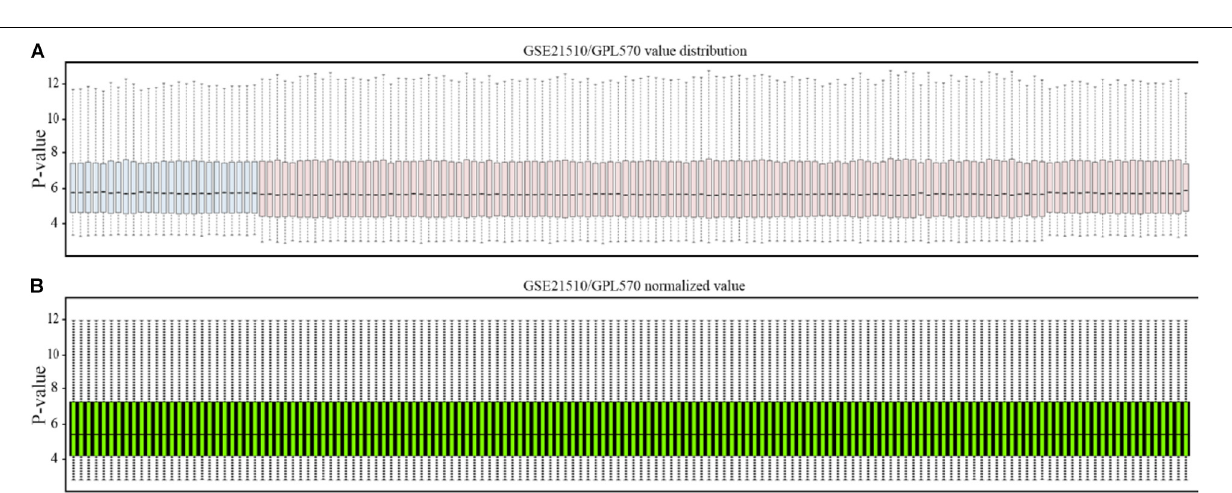
Frontiers in Genetics |